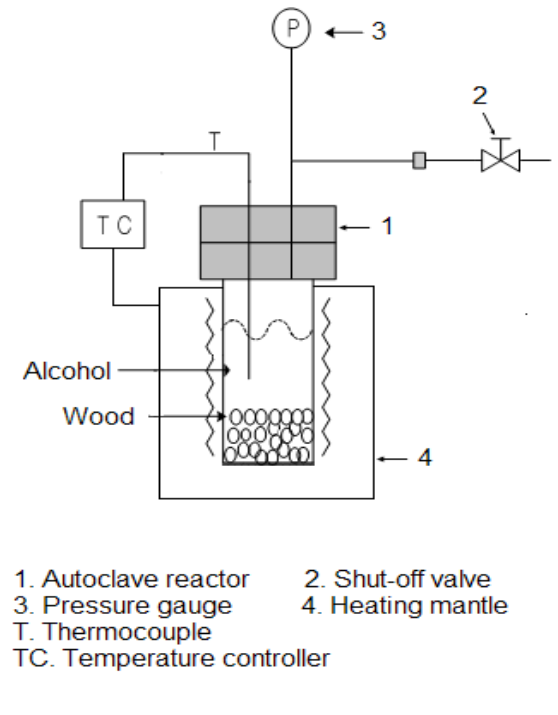
Figure 1. Schematic diagram of the experimental